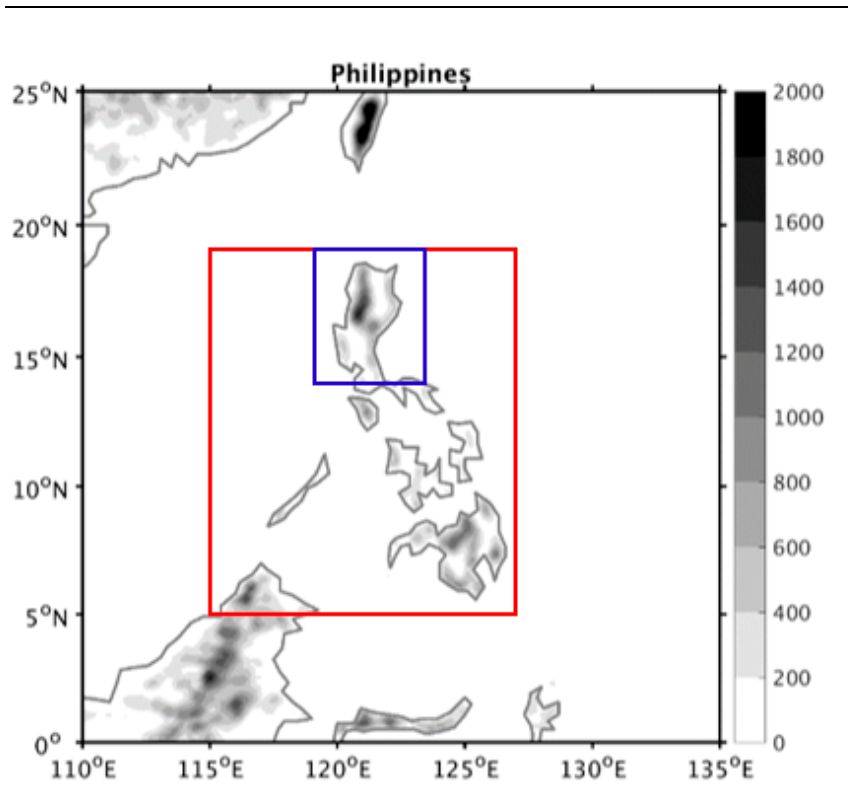
Figure 2. Philippines terrain heights (shaded in meters) and the surrounding areas. Red and blue boxes indicate the regions where the associated terrain heights are reset to plain in the terrain sensitivity experiments.